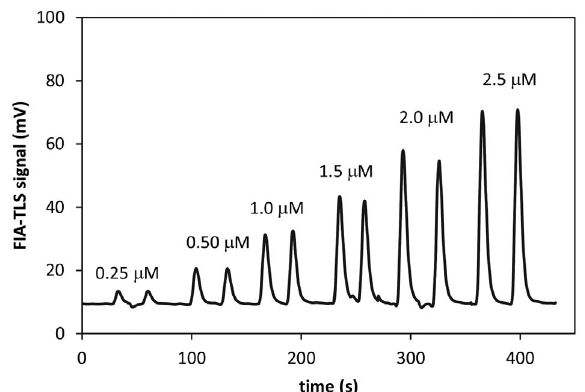
Figure 7. The TLS signal peaks of Fe(III) with 1 mM PHN as carrier solution